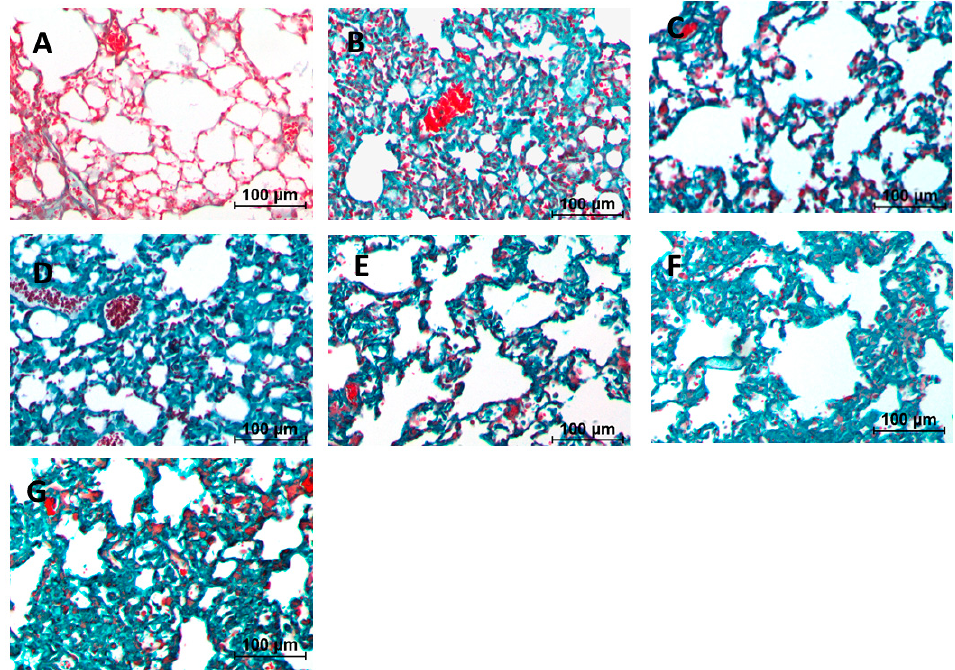
Figure 2. Effect of m KG on histopathologic changes in BLM-induced pulmonary fibrosis mice. ( A ) Normal group; ( B ) BLM group; ( C ) Pirfenidone group; ( D ) Dexamethasone group; ( E ) m KG-H group; ( F ) m KG-M group; ( G ) m KG-L group. All sections were stained with Masson trichrome and representative sections are shown at the same magnification (200×).